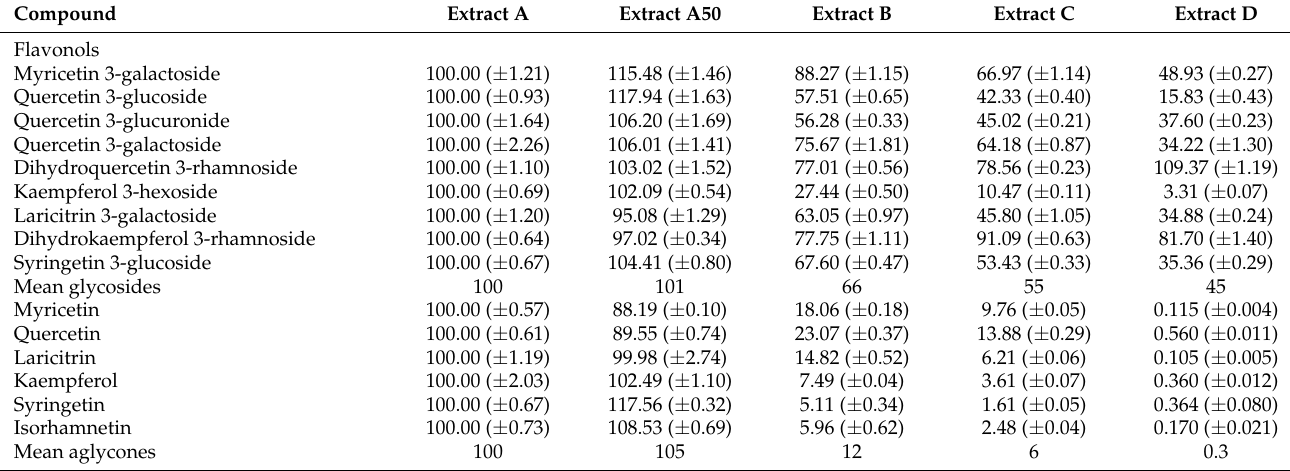
Table 11. Relative percentage (mean ± SD) of each flavonol in extracts A50, B, C and D calculated in respect to the content determined in extract A and set as 100%. The relative percentages were calculated by measuring the areas of the peaks reconstituted by setting the [M-H] − as filter